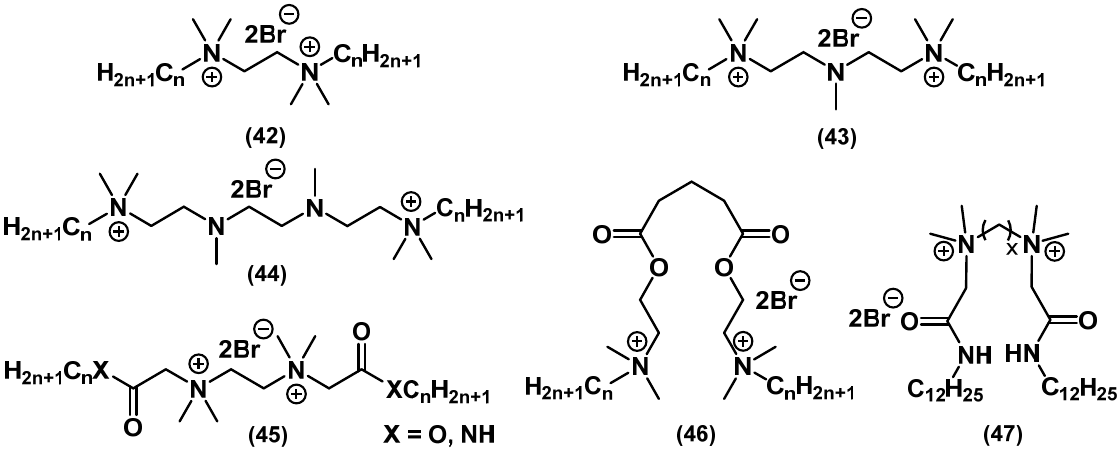
Figure 20. Alkyl bis-QACs.